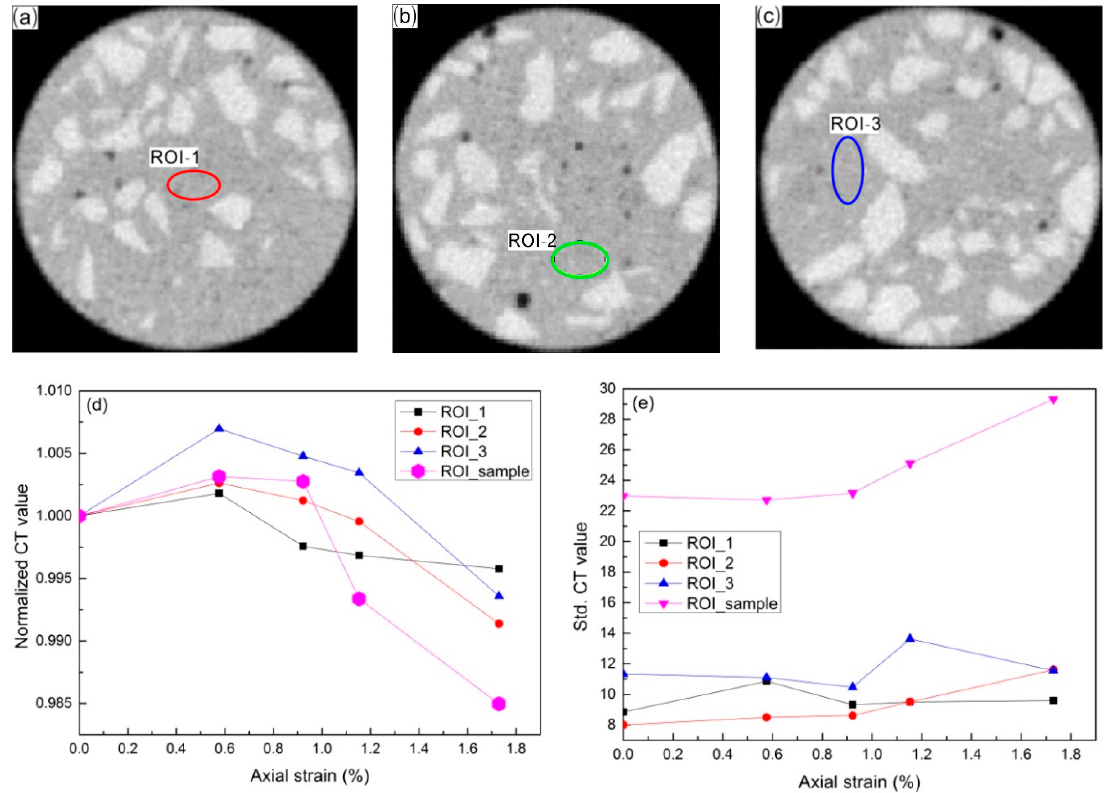
Figure 10. Meso-damage evolution of CWRB sample during deformation. ( a – c ) determination of the local region of interests, labeled as ROI-1, ROI-2, and ROI-3; ( d , e ): Relationships between the mean CT value, deviation of the CT value, and the axial strain.